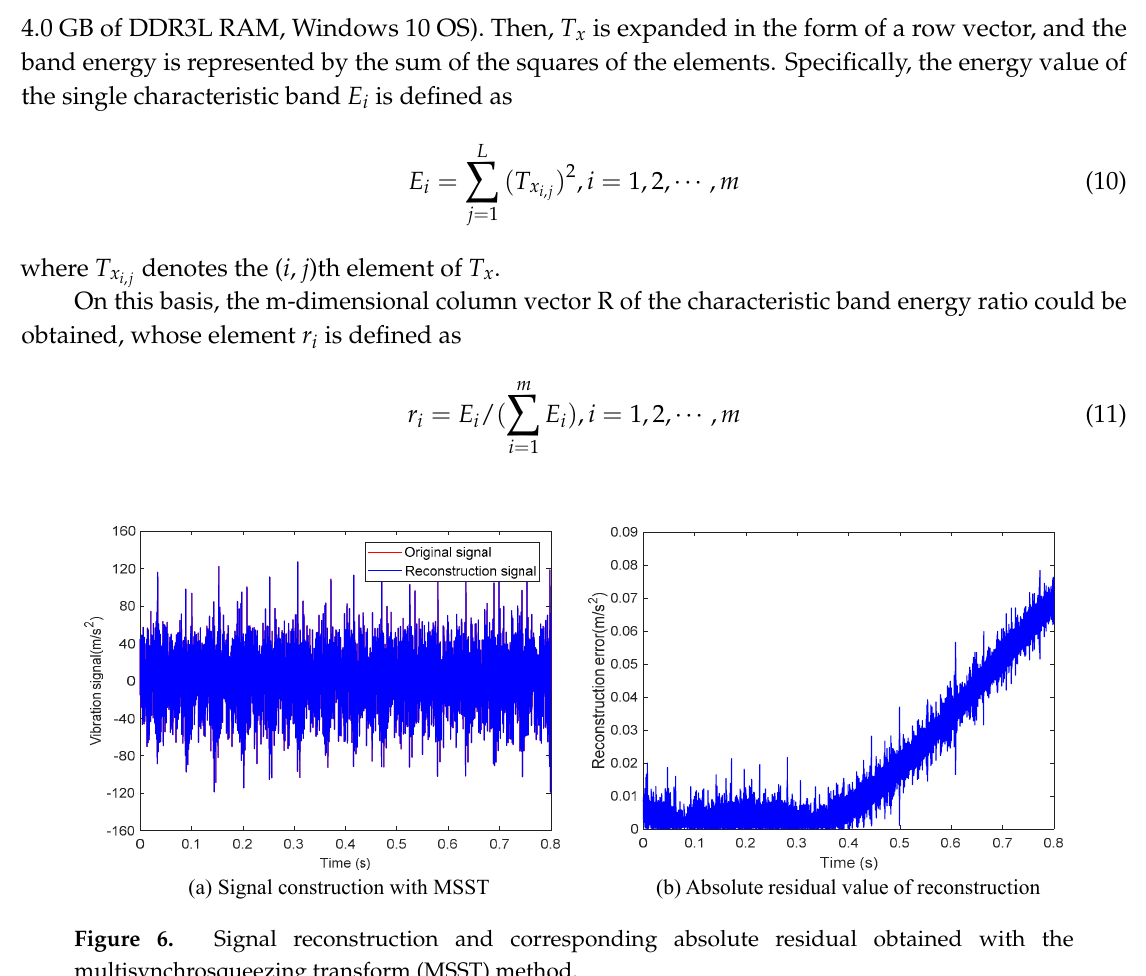
Figure 6. Signal reconstruction and corresponding absolute residual obtained with the multisynchrosqueezing transform (MSST)